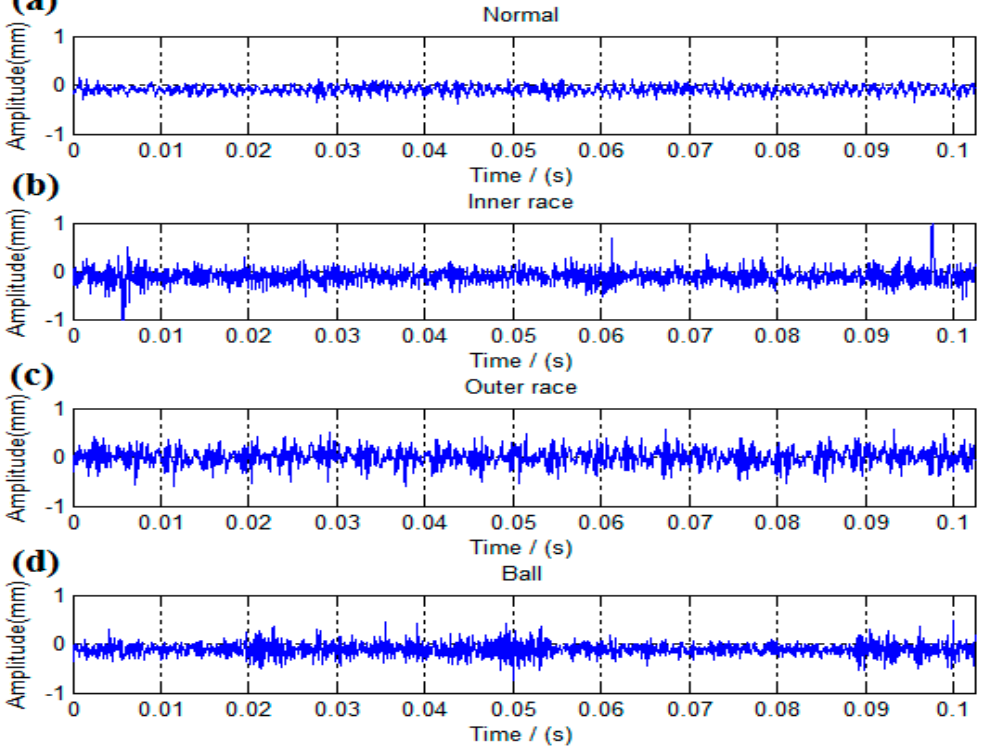
Figure 6. The time-domain diagram in rolling element bearing. The x axis is the time series and y axis is the data which is collected by the accelerators. ( a ) The waveform of normal state; ( b ) the waveform of inner race fault; ( c ) the waveform of outer race fault; ( d ) the waveform of ball fault.